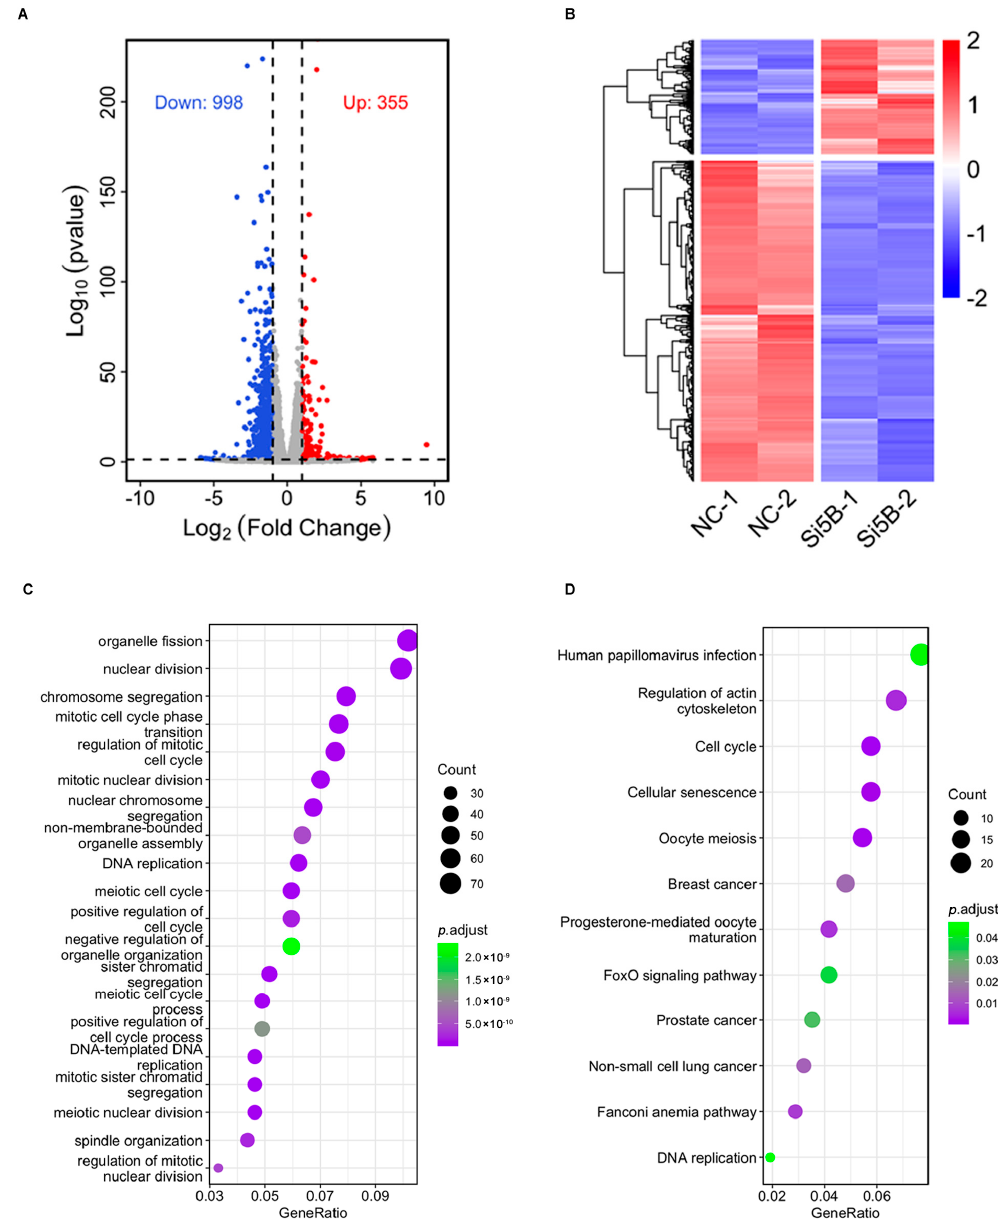
Figure 2. GO and KEGG functional enrichment analysis. ( A ) Volcanic plots display that a total of 1353 DEGs have been identified, of which 998 genes are down − regulated and 355 genes are up − regulated. ( B ) Heat map displays that the repeatability within the group is good and the difference between the groups is large. ( C ) Significantly enriched GO terms. ( D ) Significantly enriched KEGG